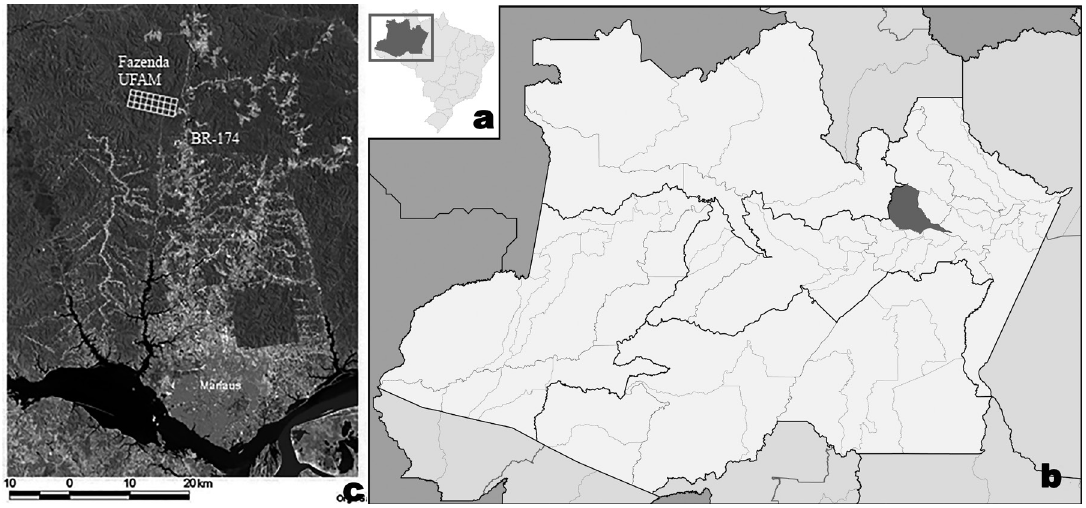
Fig. 1. Type locality of C. cabocla Feijó, Belchior, Marialva & Pessoa sp. nov., C. ielemdei Feijó, Ramires, Lima & Pessoa sp. nov., and C. menini Feijó, Picelli, Ríos-Velásquez & Pessoa sp. nov. a . Map of Brazil highlighting Amazonas state. b . Municipality of Manaus. c . Experimental farm of